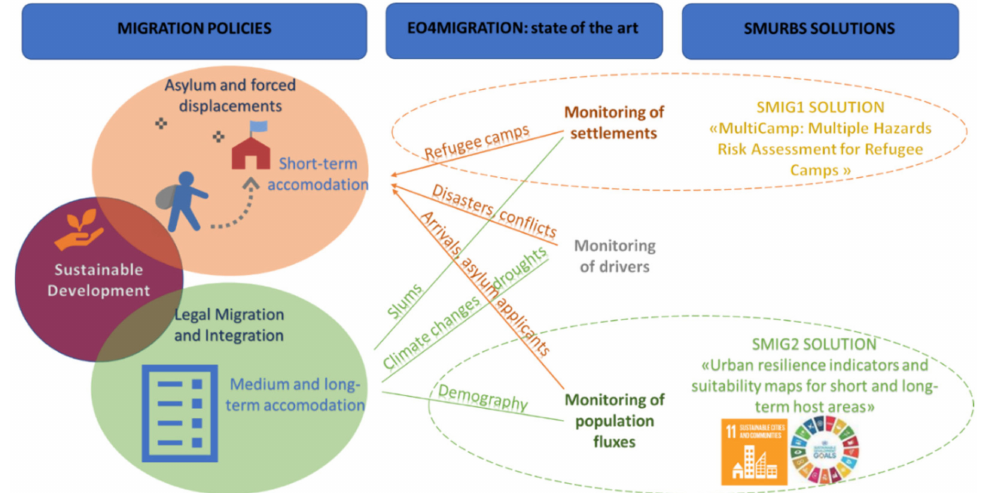
Figure 1. Schematic representation of the links between policy frames, and state of the art with respect to EO usage and the solutions proposed for the migration theme (Solutions for MIGration—SMIG) within the SMURBS